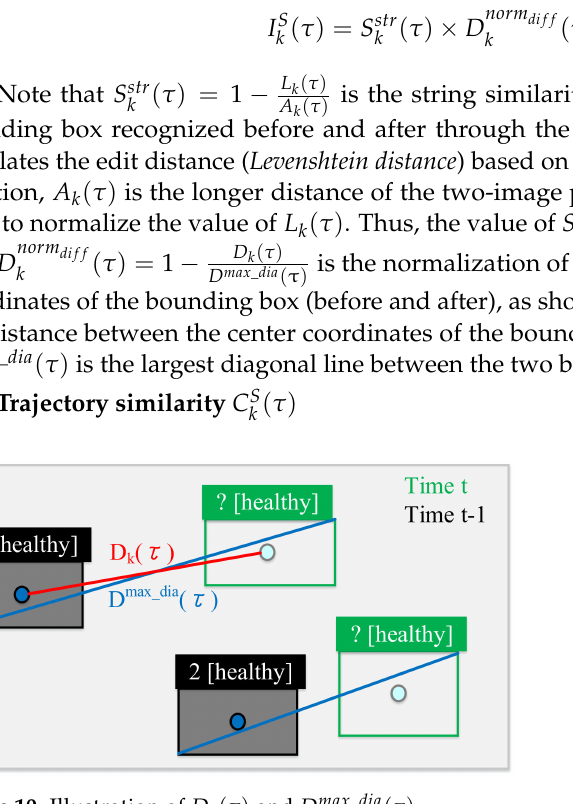
Figure 10. Illustration of D k ( τ ) and D max _ dia ( τ )